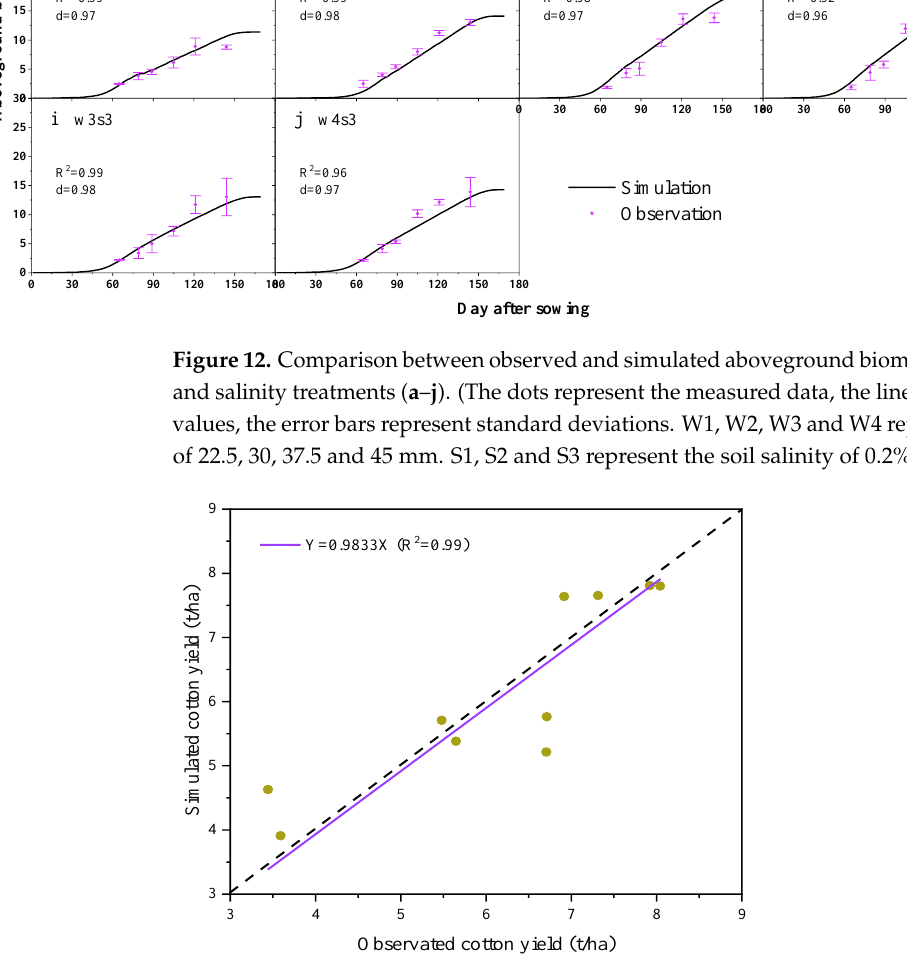
Figure 13. Relationship between AquaCrop on observation and simulation of cotton yield under different irrigation and salinity treatments. (The dots represent the relationship between observation and simulation.)